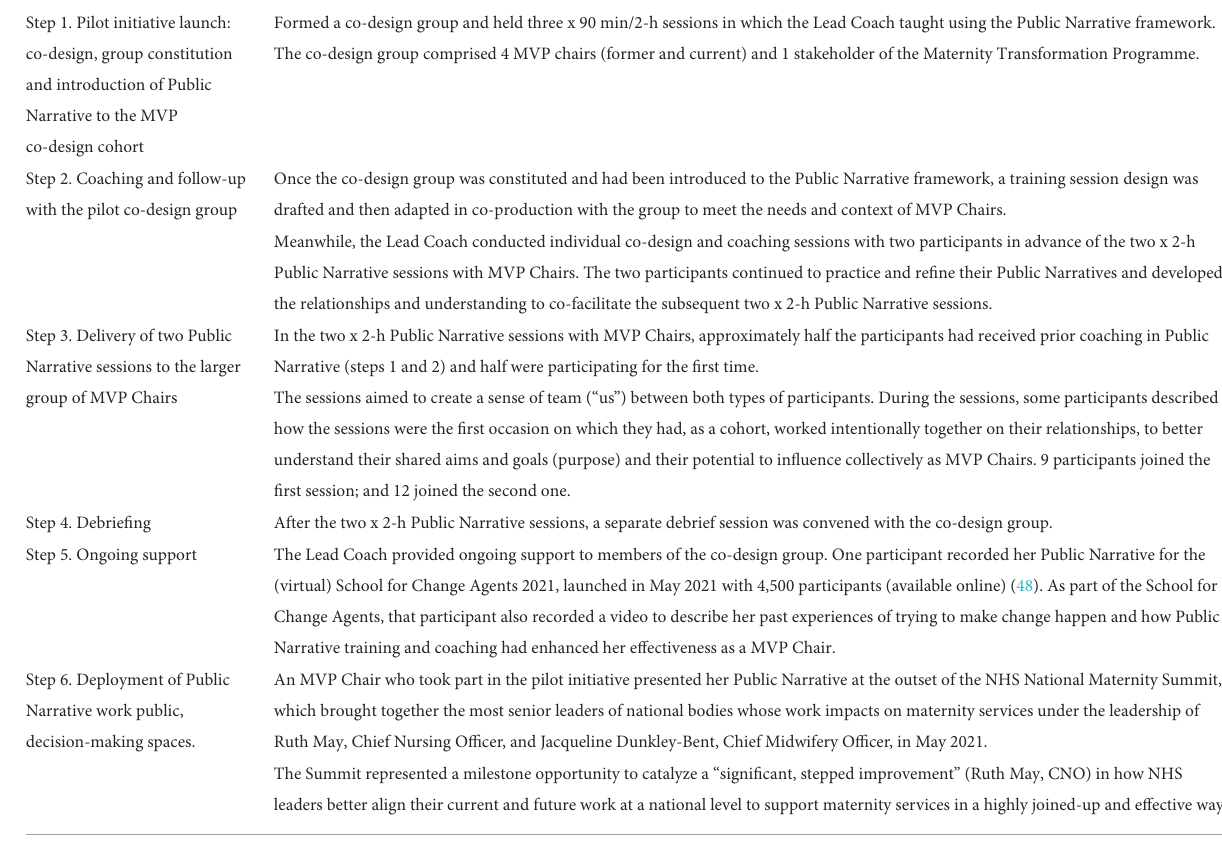
TABLE 1 Phase 1: Co-design, co-facilitation, and delivery of Public Narrative. Step 1. Pilot initiative launch: